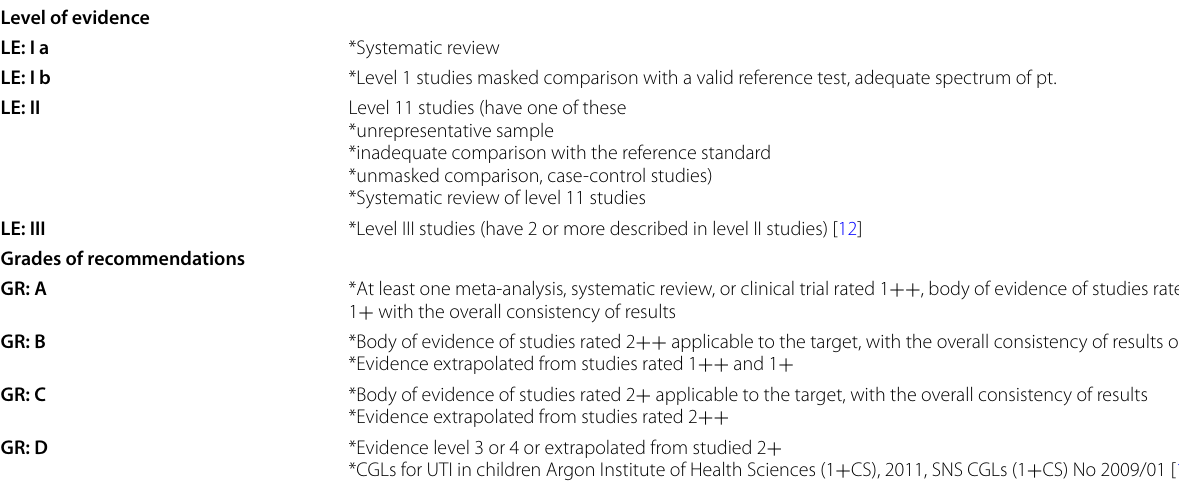
Rating evidence level in Egyptian National CGLs was related to its reference guideline as adopted after their permission. AAP used L1, L2, and L3. AAUS used L1, L2, and L3 and GR: A, B, C, and D. EAU/ESPU used L1a, L1b, and L2 and GR: A, B, C, and D